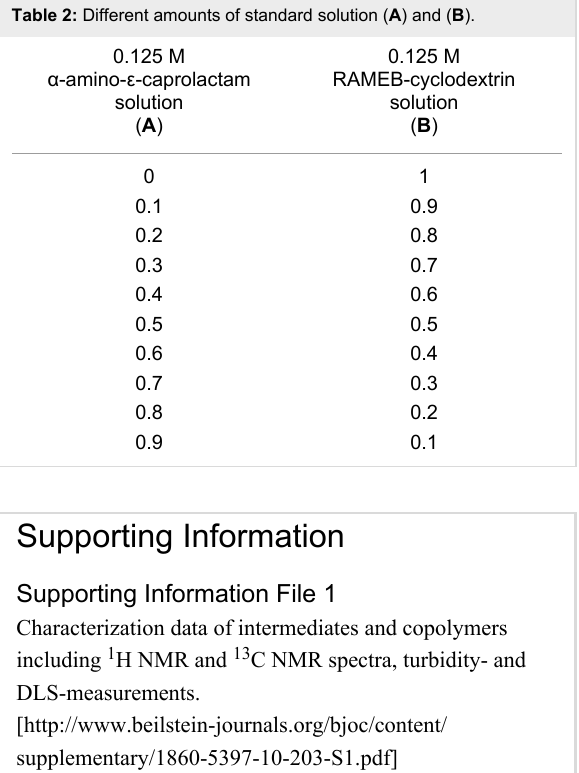
General Procedure for the preparation of the stan- dard solutions for the Job Plot analysis